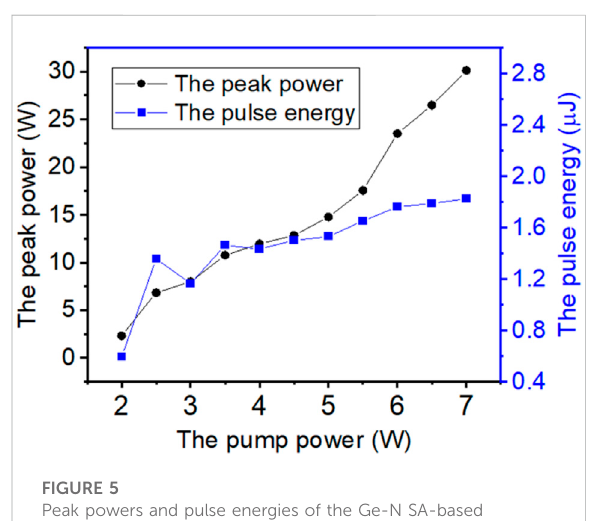
FIGURE 5 Peak powers and pulse energies of the Ge-N SA-based Q-switched Nd:YVO 4 laser versus the pump